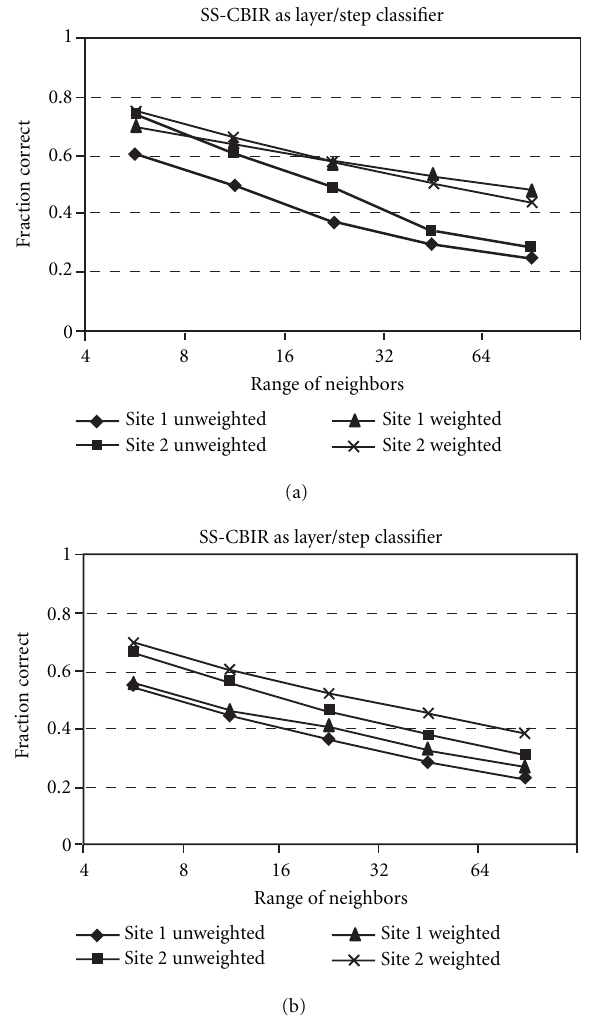
Figure 7: Results using the AIR field test system as a classifier. Plot (a) shows layer/step, and (b) lot k -NN classification results. Note that SS-CBIR refers to “semiconductor-specific